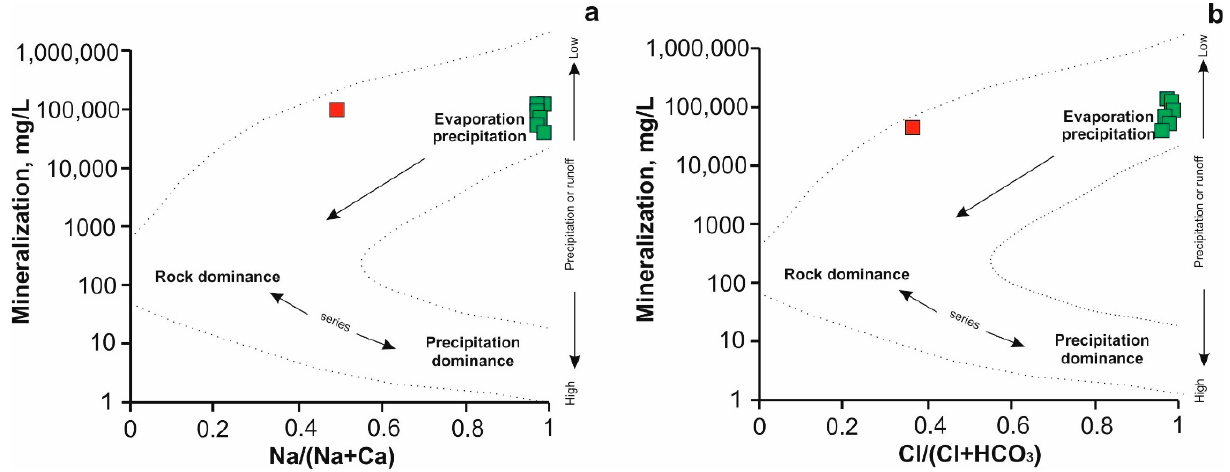
Figure 7. Dependence of mineralization on Na/(Na+Ca) ( a ) and Cl/(Cl+HCO3) ( b ) . Note. Red points—underground water, green—surface water and pore water of lake sediments.